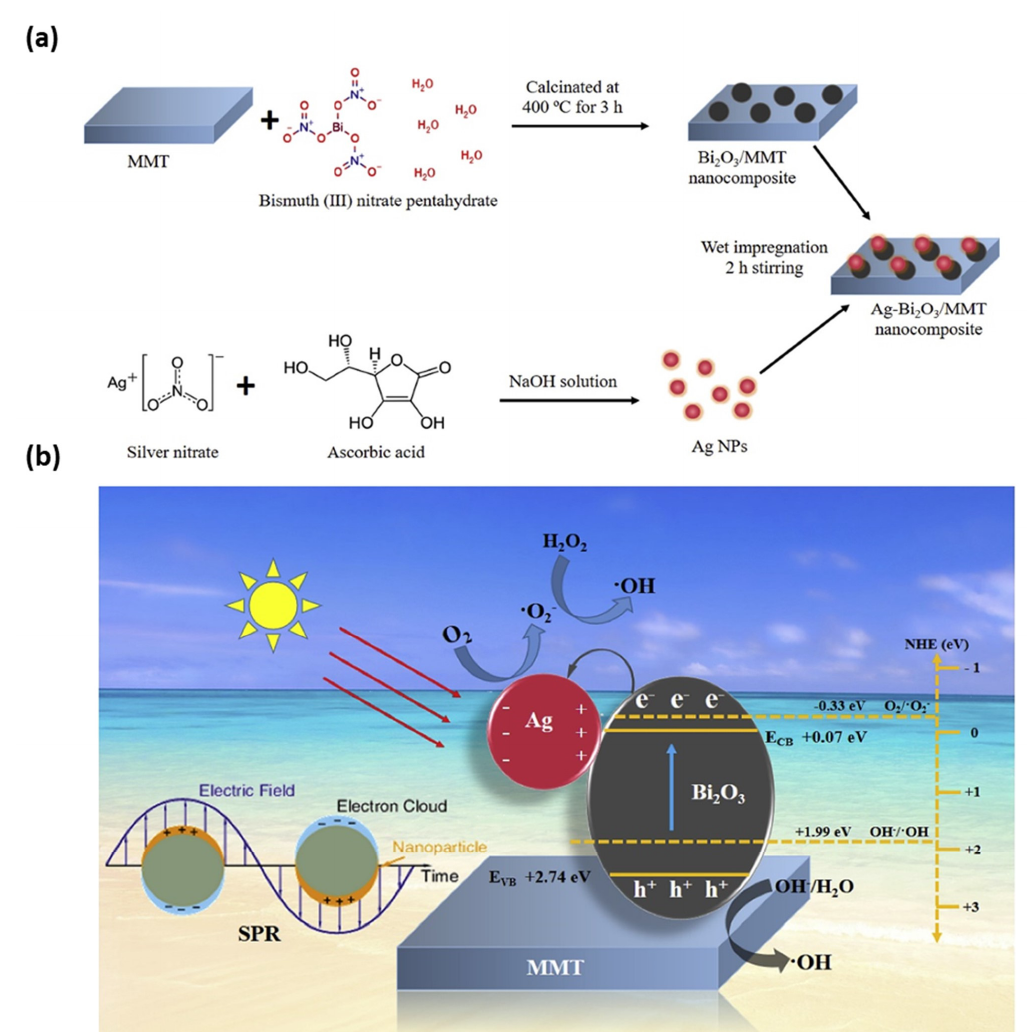
Figure 5. ( a ) Schematic diagram of the synthesis process of Ag–Bi 2 O 3 /MMT nanocomposite and ( b ) schematic representation of electron–hole separation of Ag–Bi 2 O 3 /MMT composite under visible light irradiation. Adapted from [221], with permission from Elsevier (Copyright 2020, Elsevier).